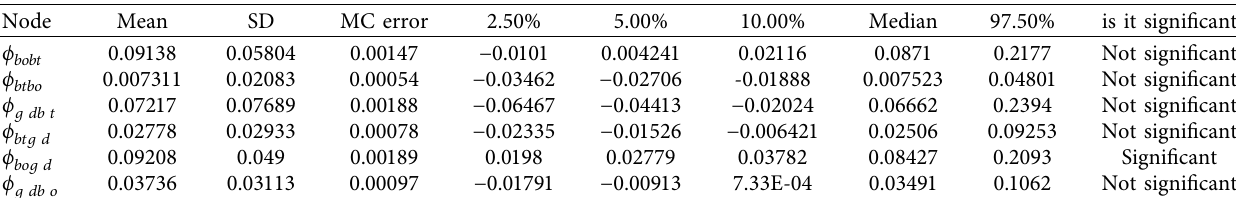
Table 4: Granger causality result between bitcoin, gold, and